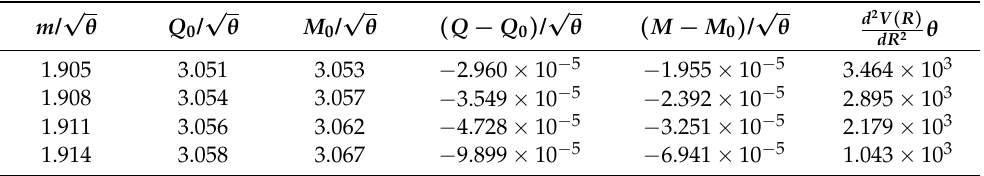
2 V ( R ) at M s = 10 − 5 . dR 2